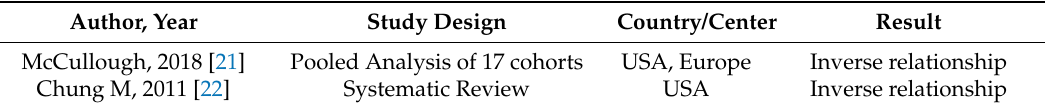
Table 3. Summary of major epidemiological studies examining the association of Vitamin D intake with